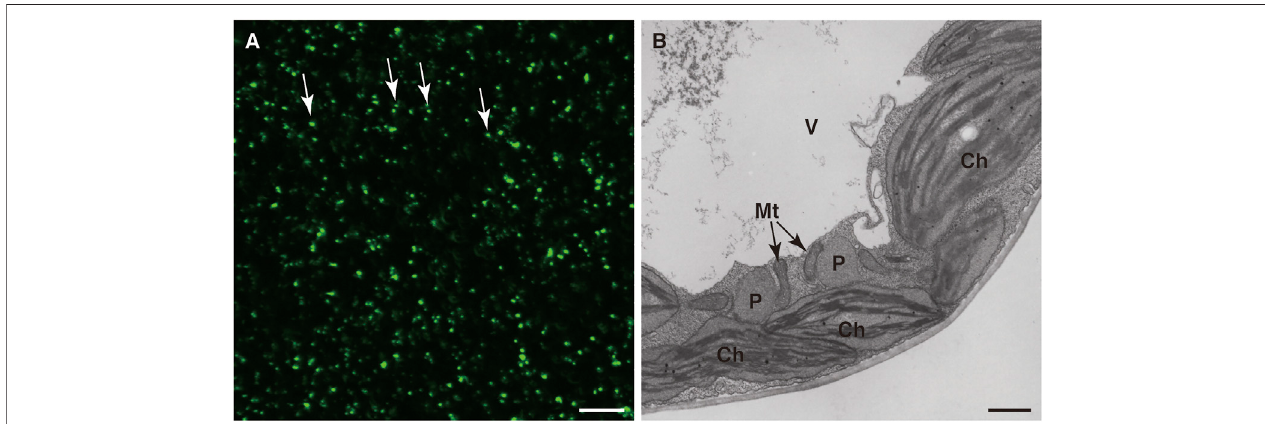
FIGURE 1 | Detection of peroxisomes in leaf cells. Fluorescence microscopic analysis of GFP (A) and electron microscopic analysis (B) were performed of transgenic A. thaliana (GFP-PTS1) expressing the fusion gene of GFP with PTS1 under the regulation of the constitutive promoter. (A) A lot of peroxisomes were visualizedassphericalstructures(JeddandChua,2002;Manoetal.,2002;Mathuretal.,2002).Somerepresentativeperoxisomesareindicatedbyarrows.Bar,20 µm. (B) Transmission electron microscopic observation of GFP-PTS1 plants (Mano et al., 2002). P, peroxisome; Mt, mitochondrion; Ch, chloroplast; V, vacuole. Bar, 1